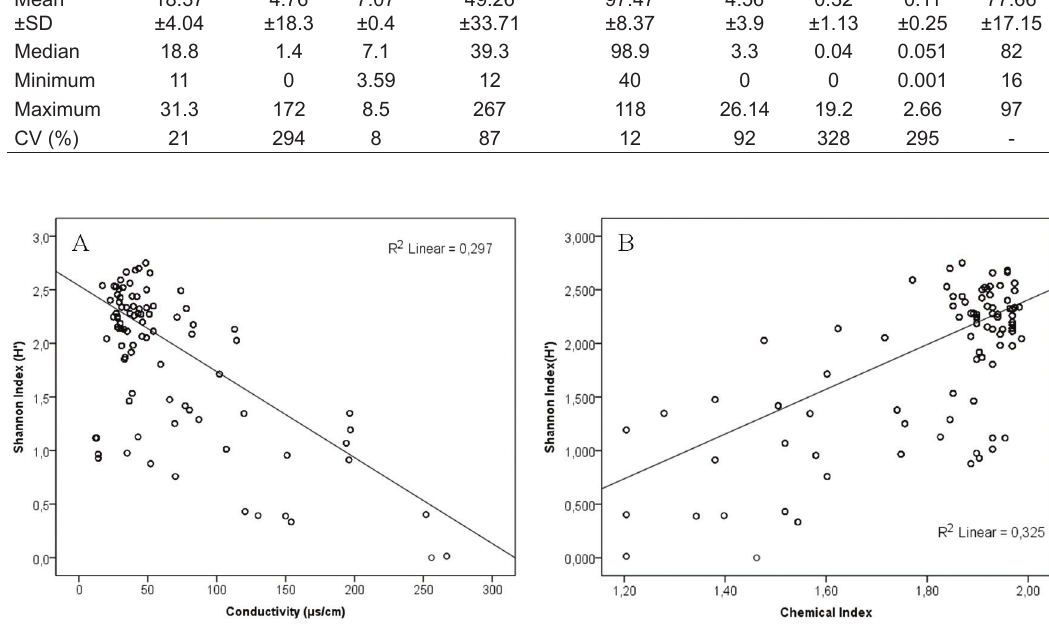
Figure 2. Regression analyses of 88 samples in 35 lotic ecosystems in the northeast region of Rio Grande do Sul, Brazil. (A) Shannon Index and conductivity (B) Shannon Index and Chemical